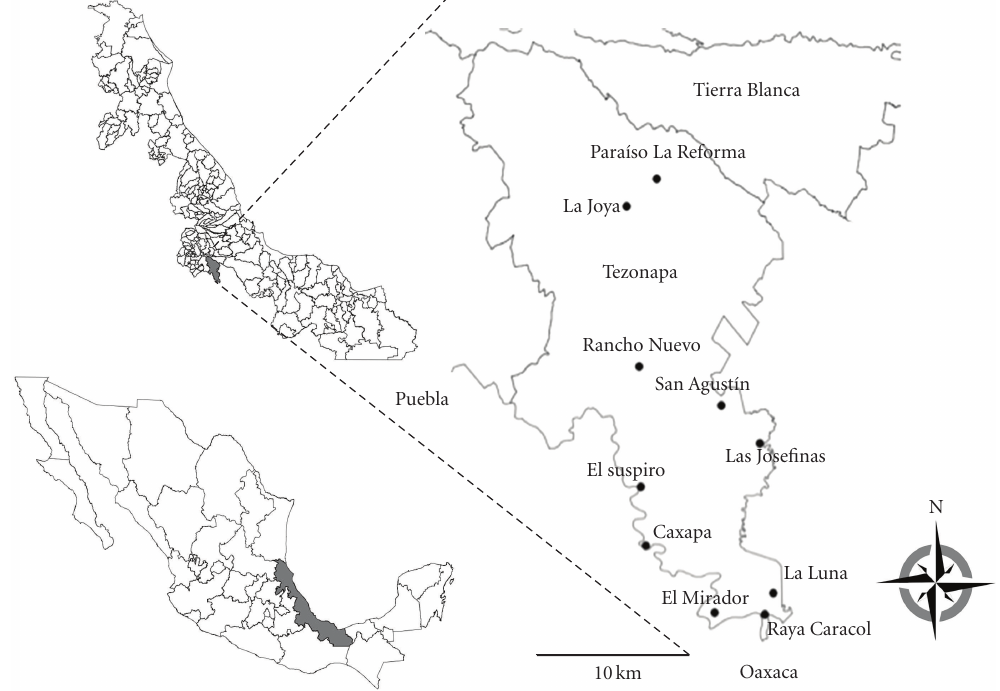
Figure 2: Study area. Mexico (bottom left), the state of Veracruz (center), and the study area (inset), corresponding to municipality of Tezonapa. Black circles show the position of the indicated